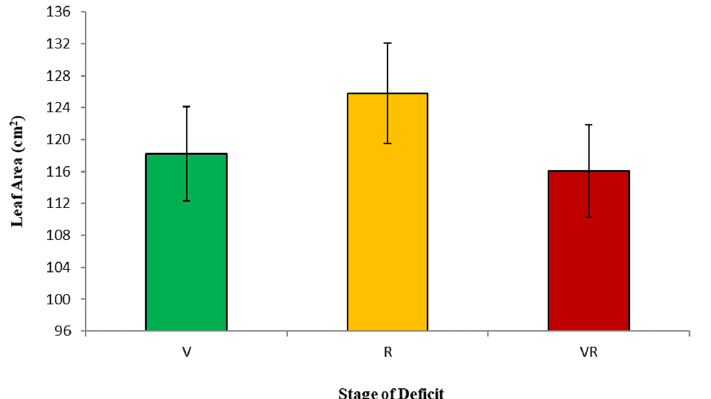
Figure 9. Effect of treatment stage on cumulative mean leaf area of okra V (vegetative), R (reproductive), and VR (vegetative and reproductive) represent the stage at which the deficit was applied. Data in the interaction analysed with Least Squares Means, and means separated with